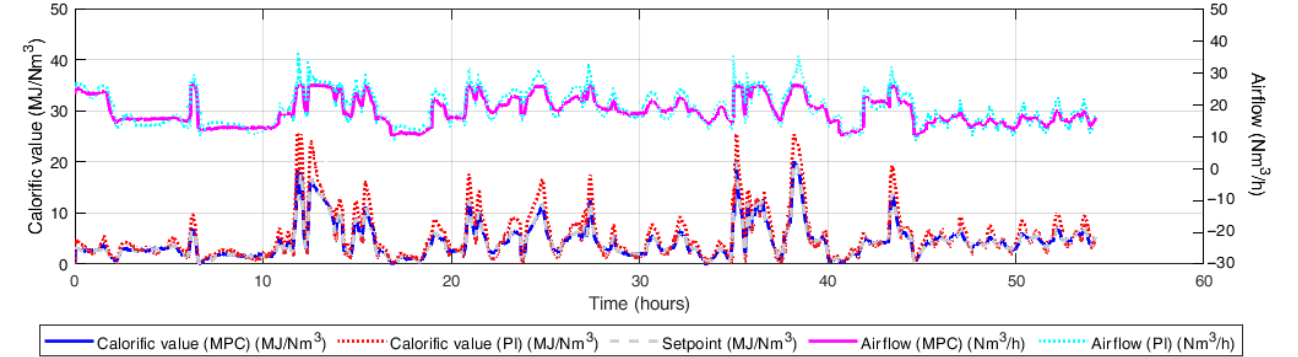
Figure 27. Syngas stabilization by the PI controller and MPC